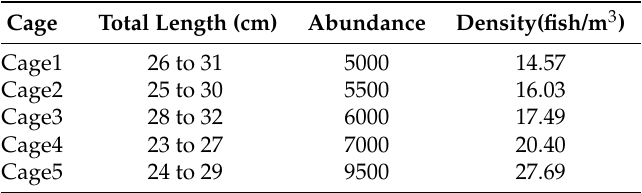
Table 8. Details of fish cages used in the